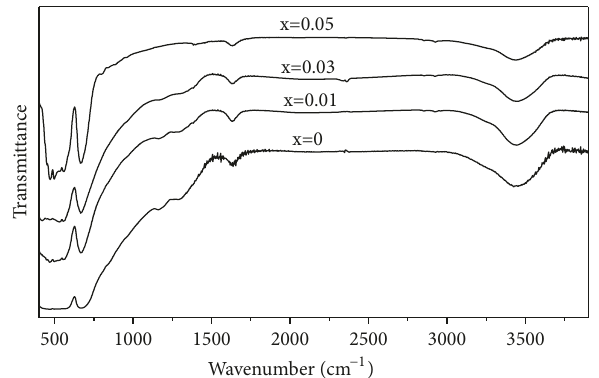
Figure 8: FT-IR spectra of (Gd 0.91